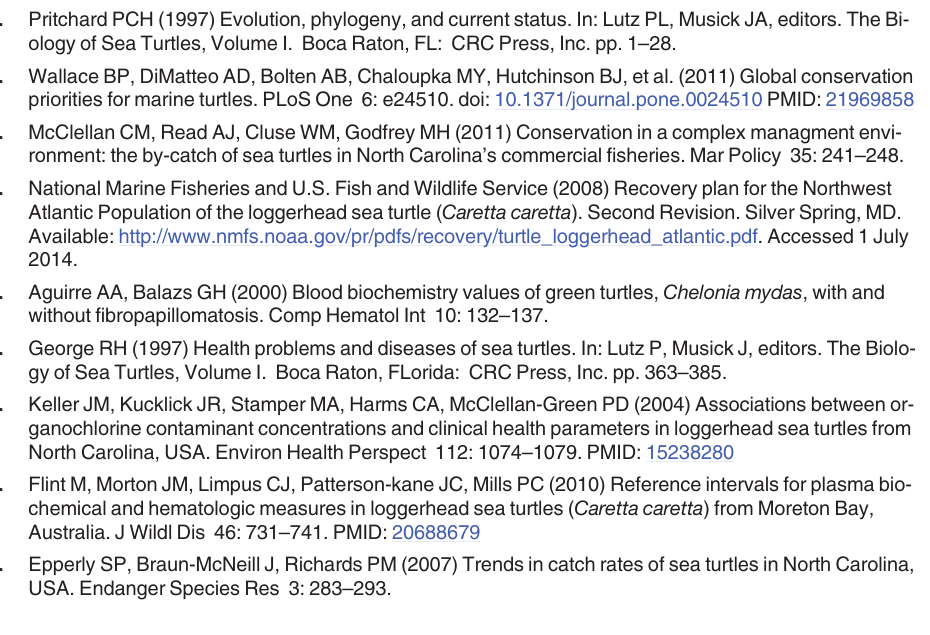
S1 Table. Demographic and clinical pathology data for juvenile loggerhead sea turtles sam- pled for this